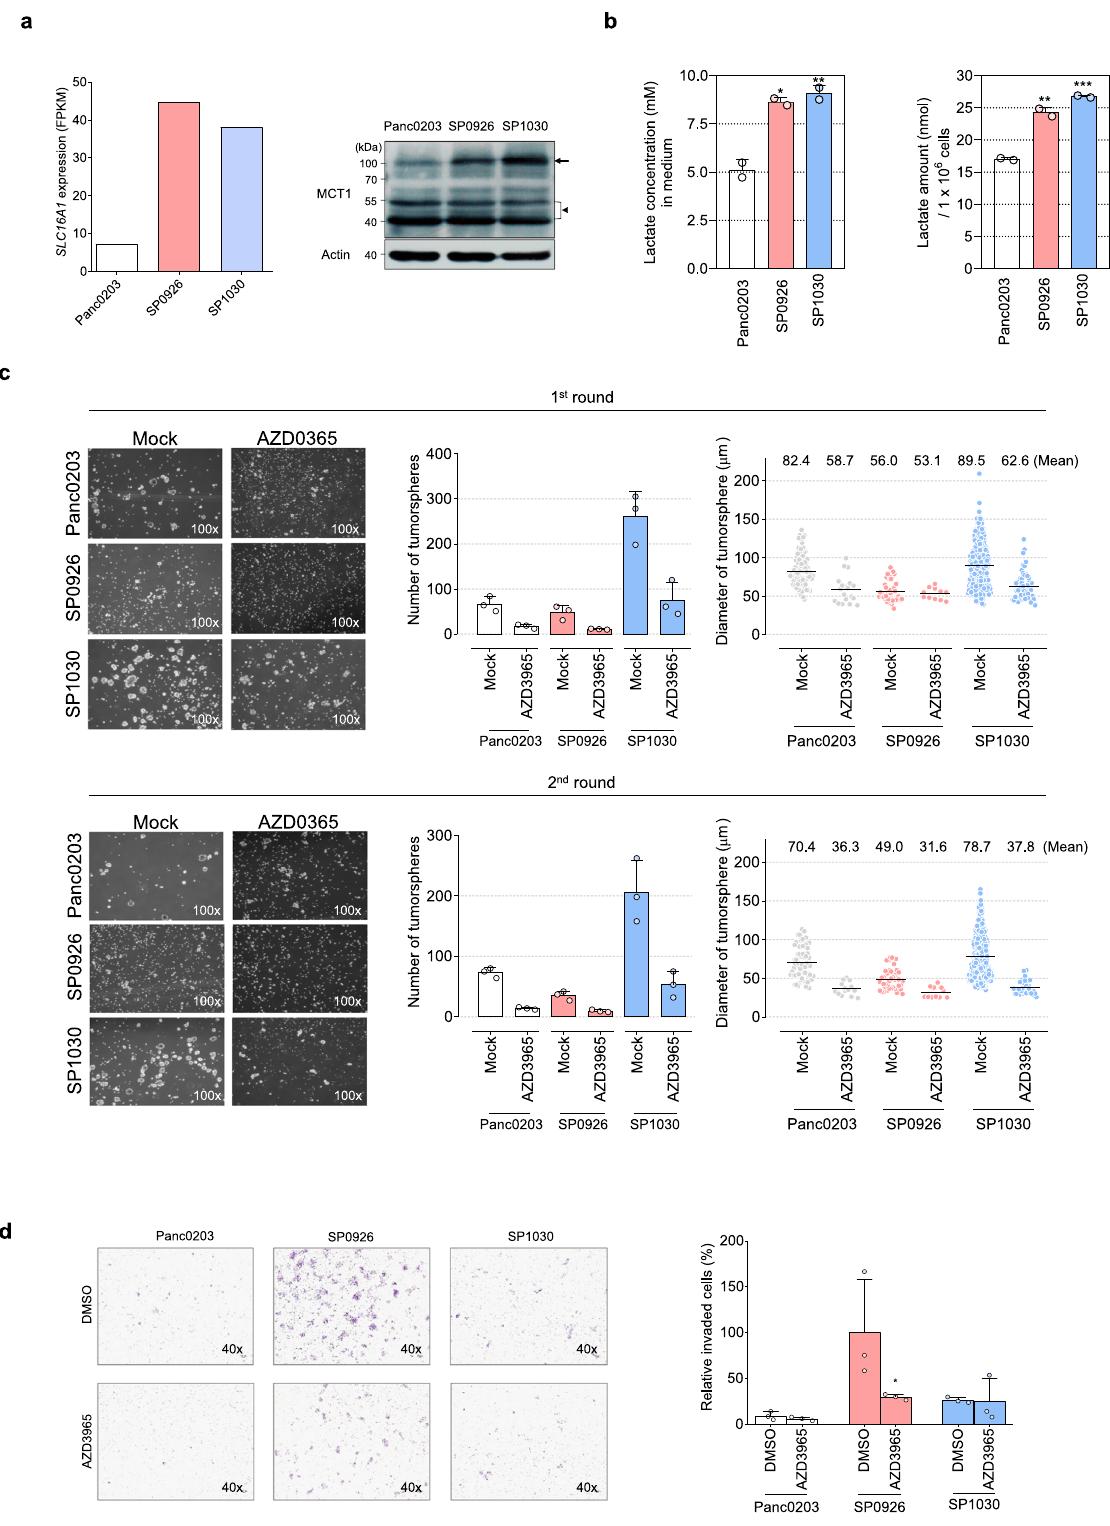
was validated using fl ow cytometric analysis for CD24 (Supple- mentary Fig. 5f). In addition, inhibition of CD24 using blocking antibody or shRNA resulted in a change in the spatial growth patterns of SP1030 and Panc0203 cells from cluster formations into dispersed single cells (Supplementary Fig. 5g). These